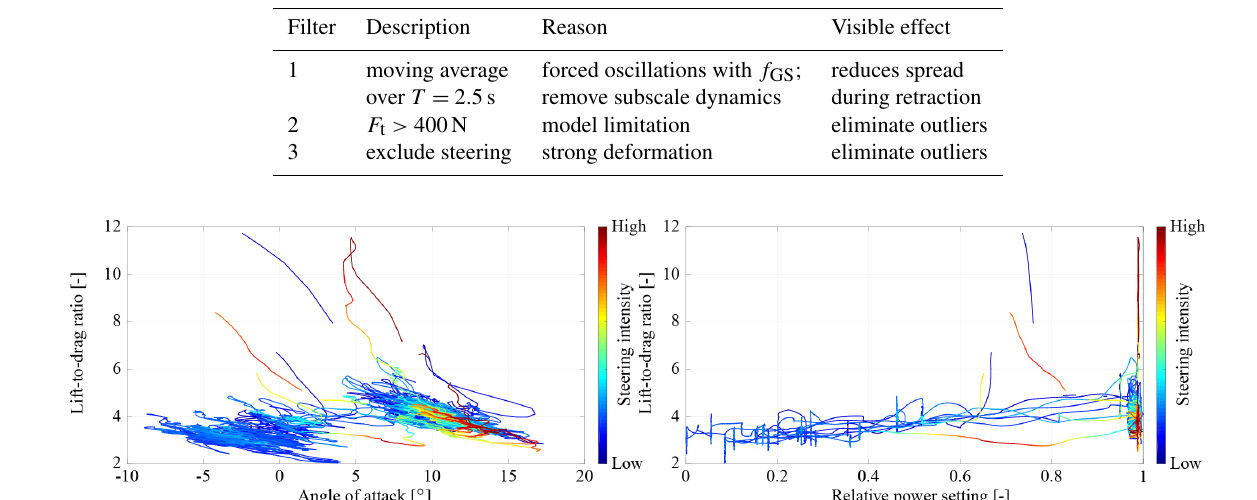
Figure 16. Measured lift-to-drag ratio L/D of the kite plotted over the angle of attack α of the wing and colored by the relative power setting u p , colored by the steering intensity ranging from blue for no steering up to yellow and red for strong steering actuation during turning maneuvers. Table 2 filters no. 1 and no. 2 have been